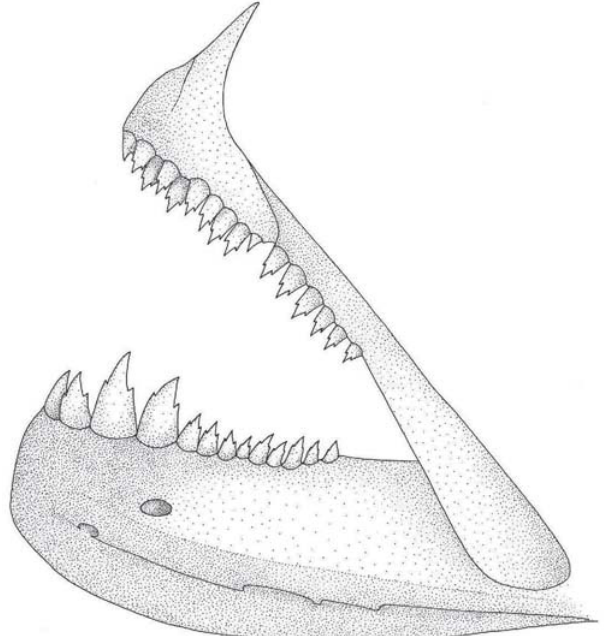
Fig. 51. Mimagoniates pulcher , developing male, MNRJ 4233, 34.2 mm SL; jaws and dentition, lateral view, right side, anterior at left.